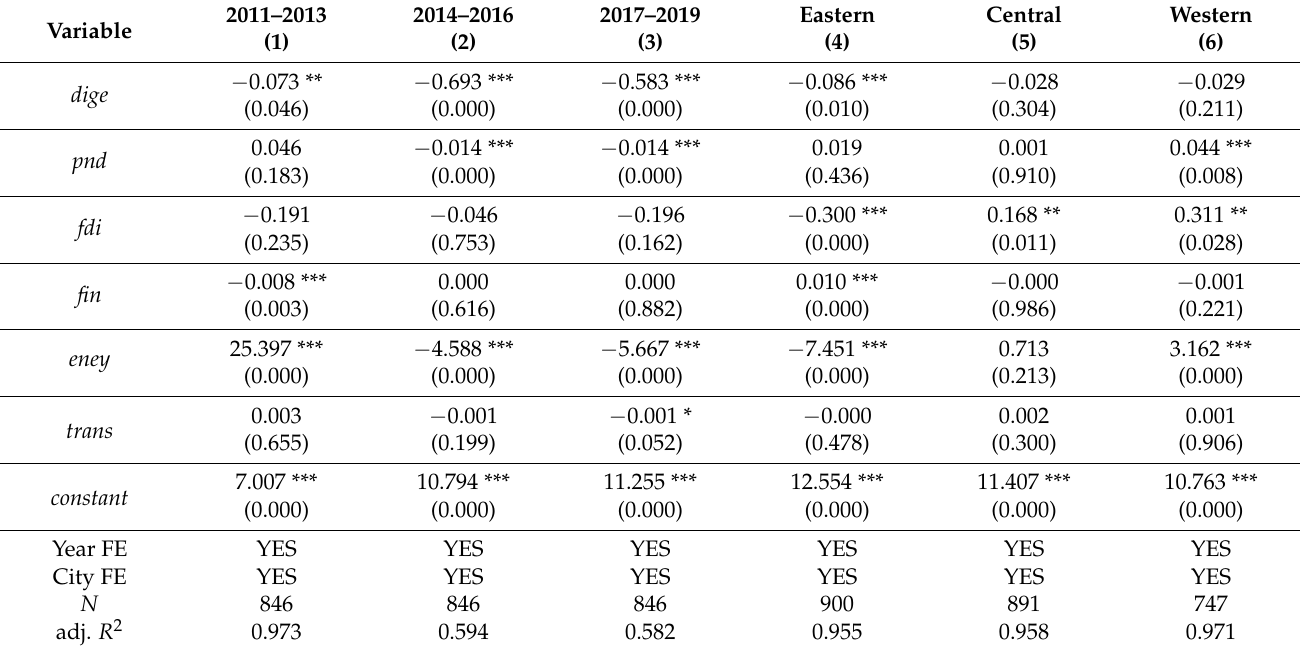
Table 10. Temporal and spatial heterogeneity.